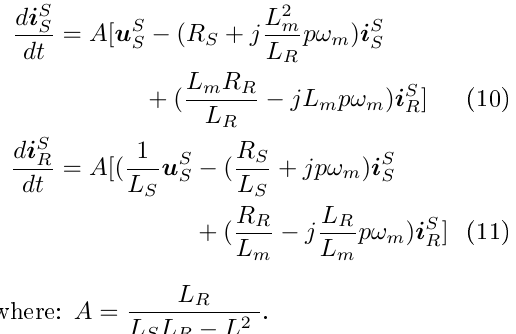
Fig. 4. Shape Wave Flow Control Hysteresis. As a result, the IM drive system can be controlled to adapt the speed and torque changes by the HPWM technique without current sensors.